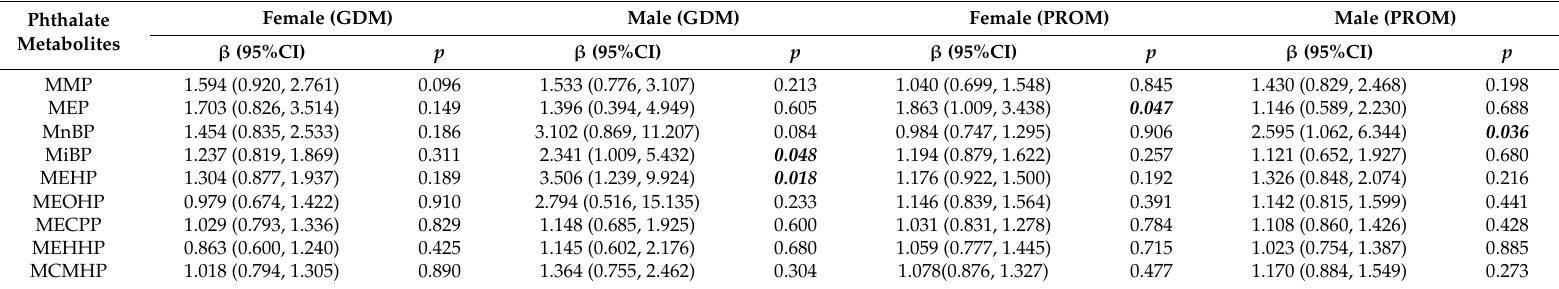
Table 6. Logistic regression analysis of relationship between the phthalate metabolites and GDM and PROM in male and female newborns.